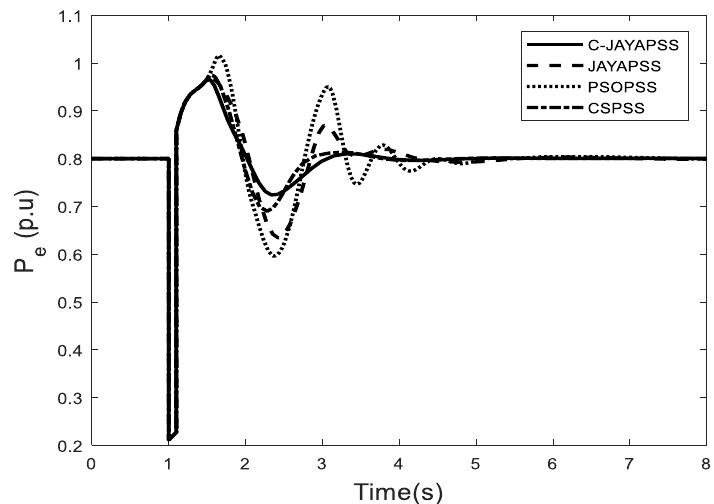
Figure 11. Rotor angle response for a six-cycle fault disturbance with case 2.